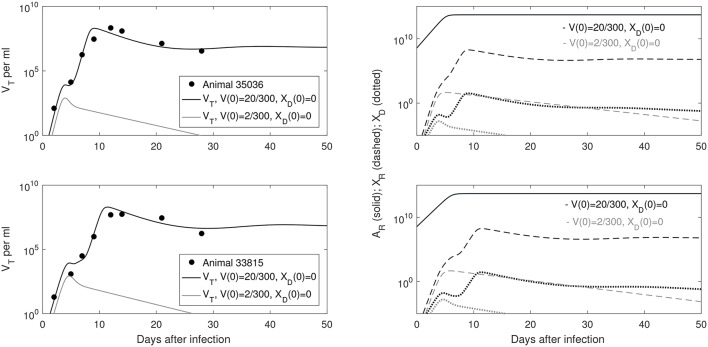
(Left) Basin of attraction for VT given by (6) vs. data; (Right) Free antibody (solid lines); recipient immune complexes (dashed lines) and donor immune complexes (dotted lines) for V(0) = 20/300 vRNA copies per ml, XD(0) = 0 vRNA copies per ml (black) and V(0) = 2/300 vRNA copies per ml, XD(0) = 0 vRNA copies per ml (gray). Note that antibody populations are identical regardless of initial conditions (solid black and gray lines overlap).